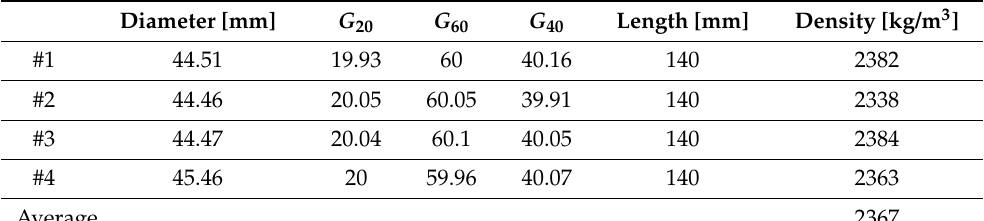
Figure 3. Last recorded image of the spalling test n°2: full-field displacement data are being extracted in the red box. Table 1. Initial dimensions and calculated density of the samples tested in spalling.